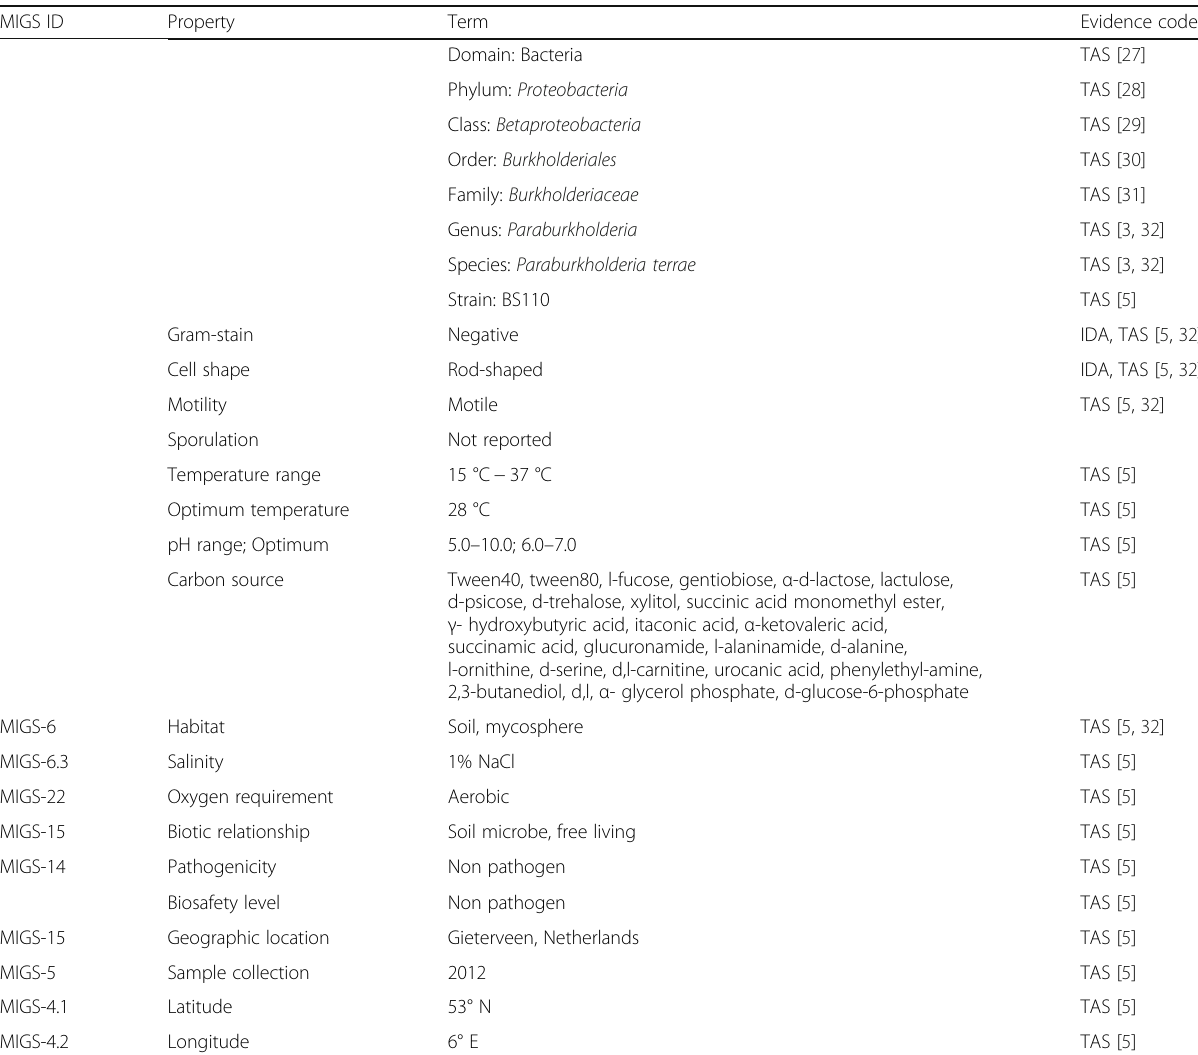
Table 1 Classification and general features of Paraburkholderia terrae strain BS110